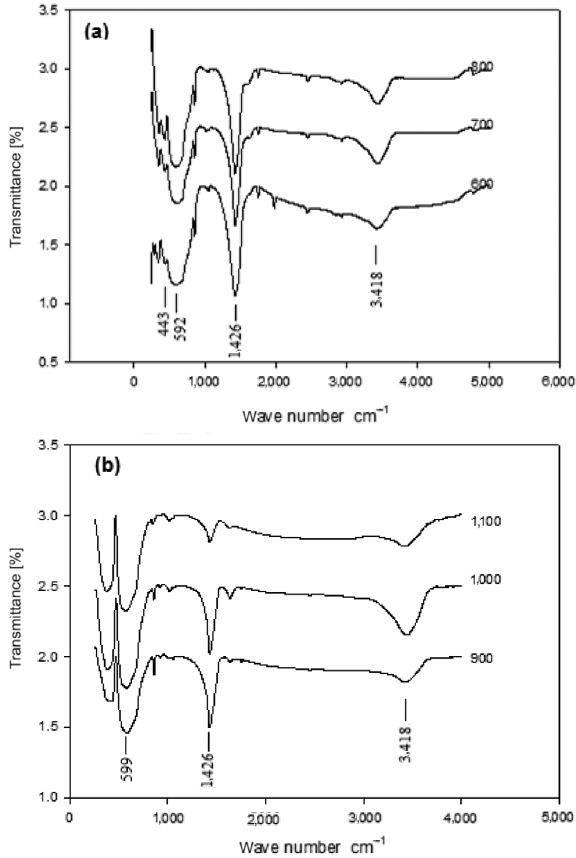
Figure 5: FTIR spectra for Ba 0.85 Sm 0.1 TiO 3 at different annealing temperature.